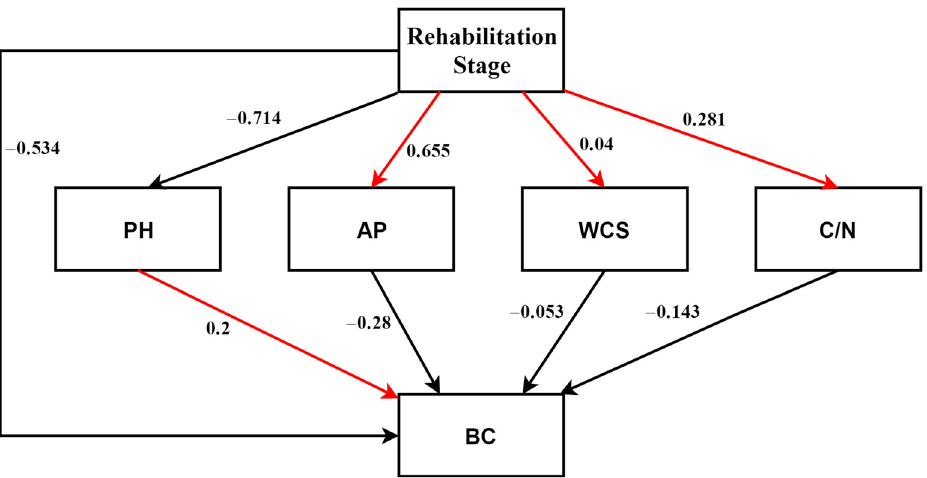
Figure 6. Directed graph of the partial least squares path model (PLS-PM). Each box represents an observed variable. Path coefficients are reflected in the arrow width with red and black indicating positive and negative effects, respectively. For the best model represented here, the GoF value was 0.28. Partial regression coefficients are written on the bars and shown variables of pH, soil pH; AP, available phosphorus; WCS, soil water content; CN, soil C/N ratio; BC, bacterial community.